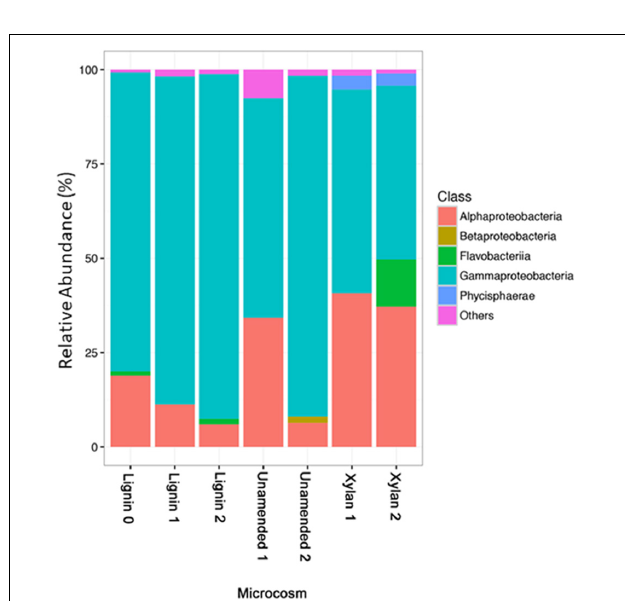
FIGURE 5 | The relative abundances of taxonomic classes identified by 16S rRNA gene amplicon sequencing. Classes that are less than 1% relative abundances are aggregated as